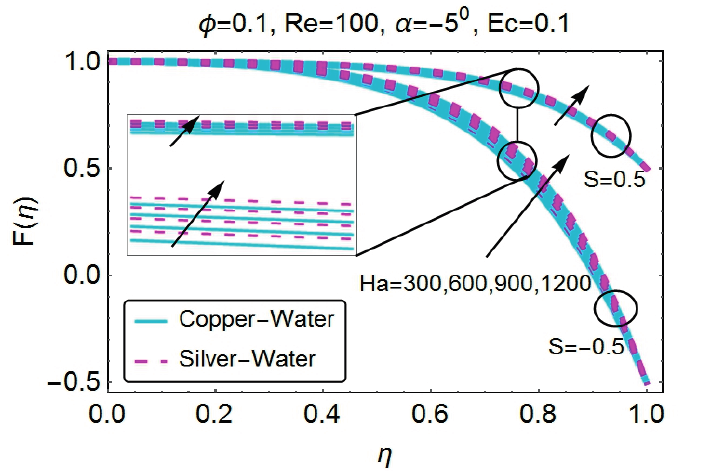
Figure 7. Change in velocity for varying Ha (convergent channel).